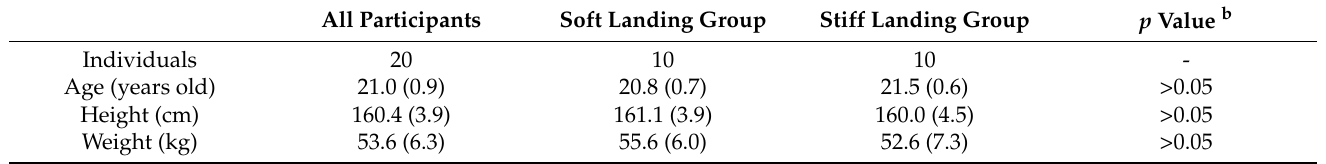
Table 1. Participants’ information a